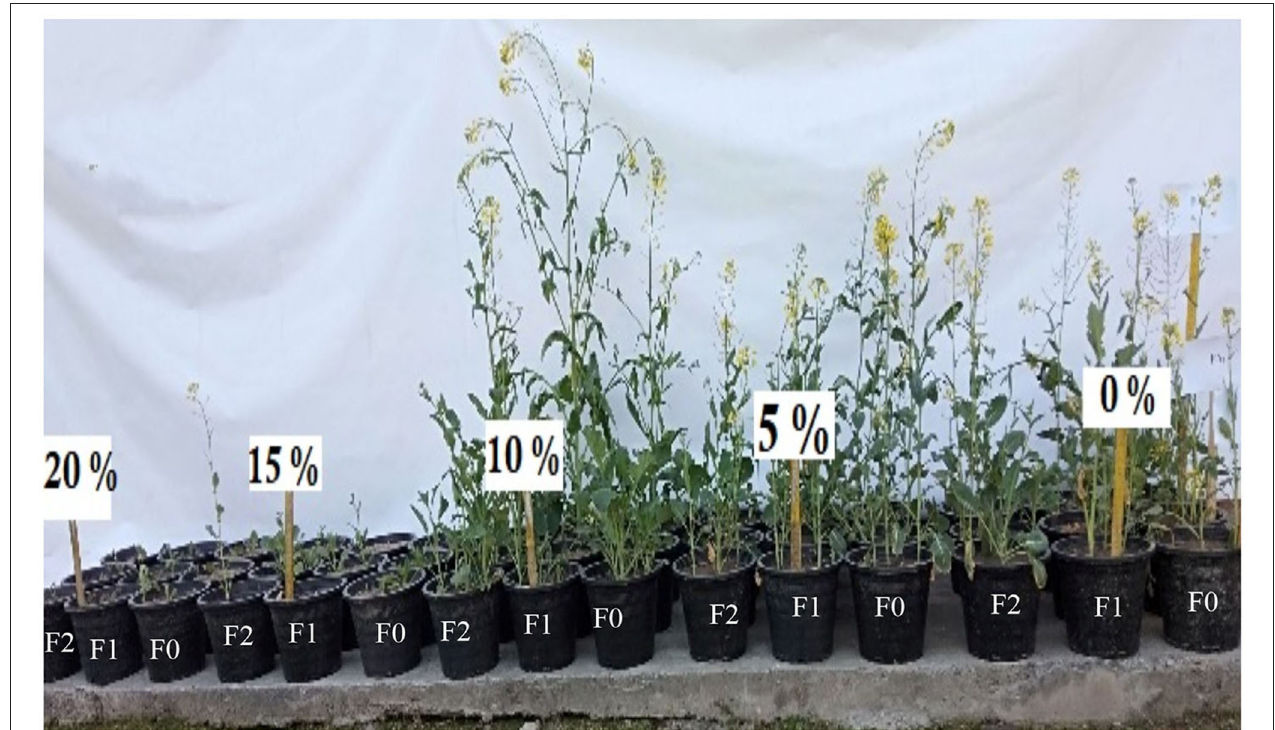
FIGURE 2 | A complete view of the experiment at various concentrations of PS (0–15%) and FA (0, 10, and 20%; F0, F1, and F2) at the time of harvesting.